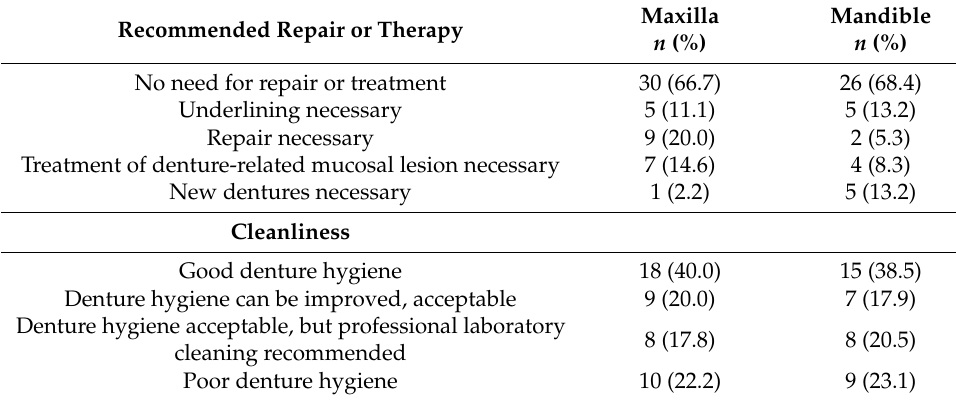
Table 2. Prosthetic treatment needs of removable dentures.